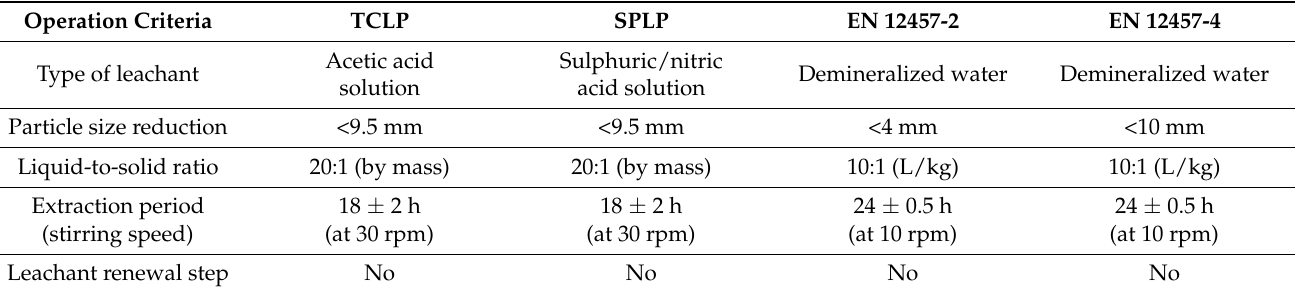
Table 3. Operational criteria of the leaching tests according to TCLP, SPLP, EN 12457-2 and EN